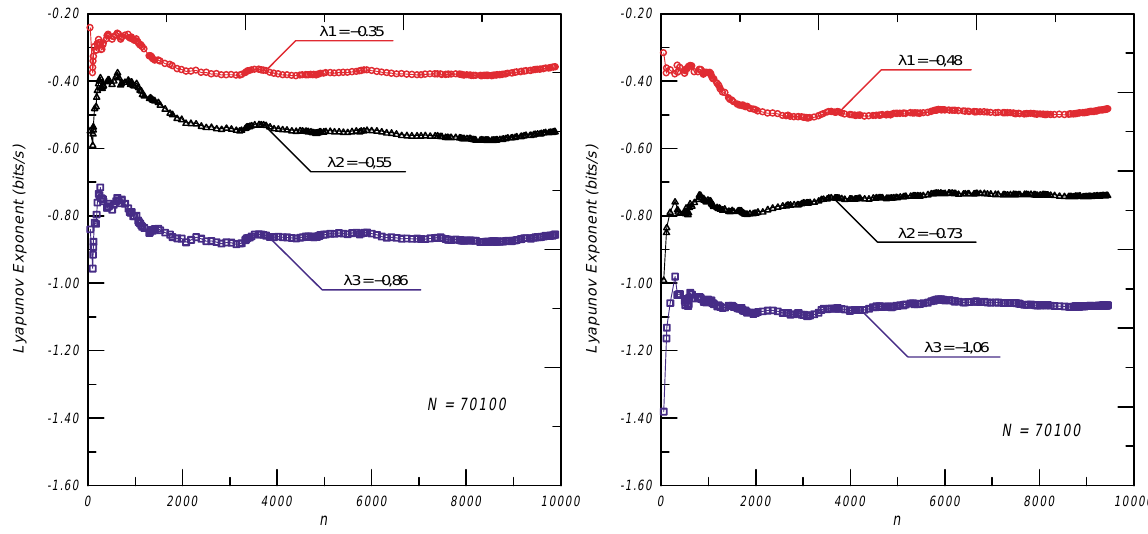
Fig. 15. Spectrum of Lyapunov exponents obtained from the algorithm due to Sano and Sawada: Noisy chaotic signal. (a) A = 0.314; (b) 0.628. large data points to estimate the Lyapunov